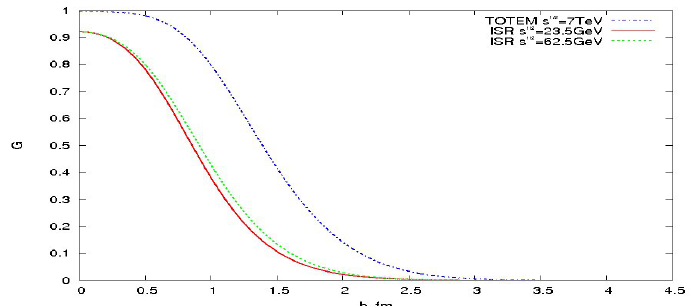
Figure 7. The overlap function G ( s , b ) at 7 TeV (upper curve) [38] compared to those at ISR energies 23.5 GeV and 62.5 GeV (all of them are computed by using the fit of experimental data according to the phenomenological model [39]). The impact parameter, b , is defined as the transverse distance between the trajectories of the centers of the colliding